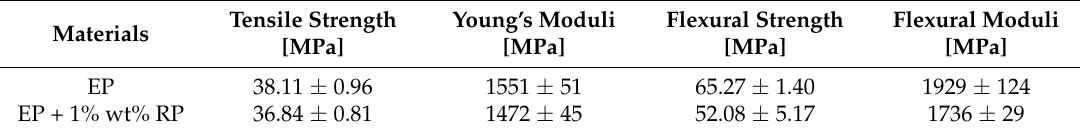
Table 1. Results of tensile and three-point bending tests of rubber-filled EP and pure EP.